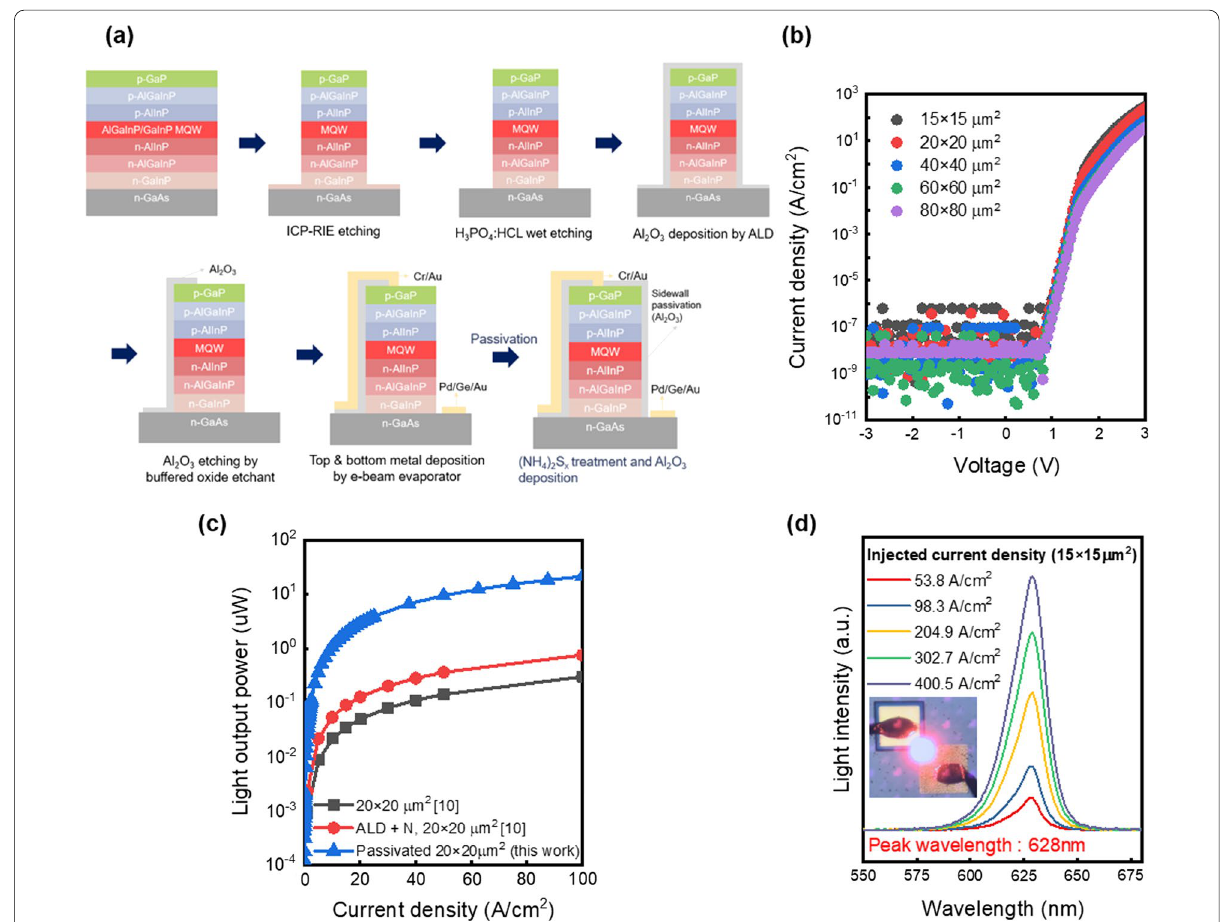
Fig. 1 a The process flow of AlGaInP/GaInP MQW LED with passivation. b The current density–voltage ( J – V ) characteristic of AlGaInP/GaInP MQW LED depending on device sizes. c The current density–light output power ( J – L ) characteristics of